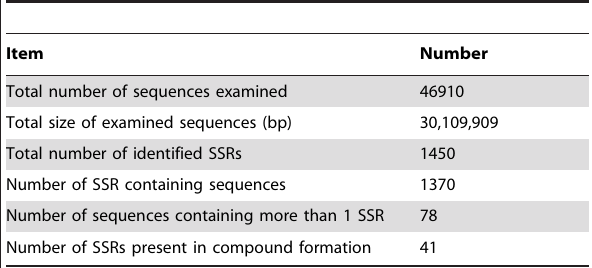
Table 4. Statistics of SSR searching